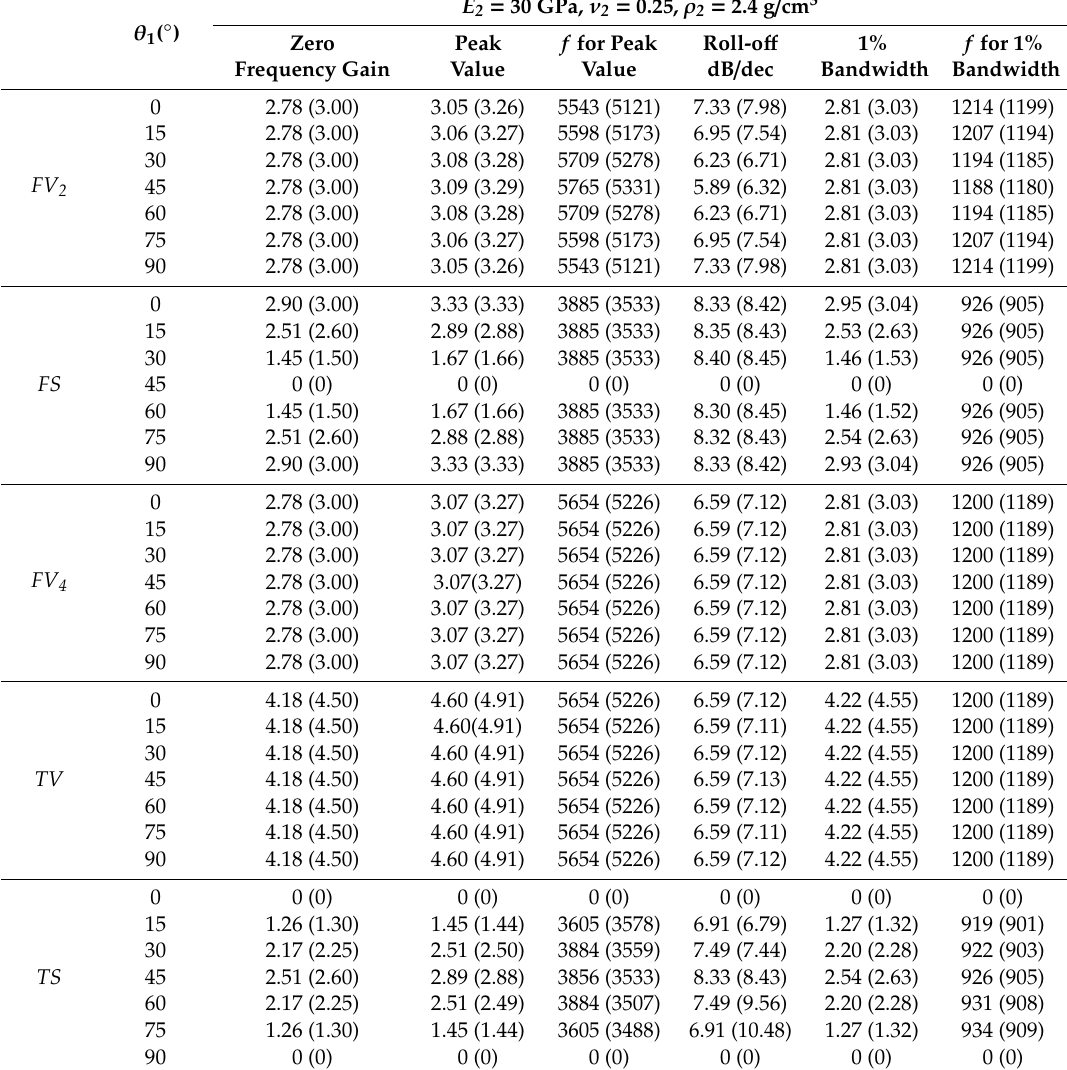
Table 1. Characteristic values for the incident P wave amplitude spectrum of FV 2 , FV 4 , FS, TV and TS at di ff erent θ